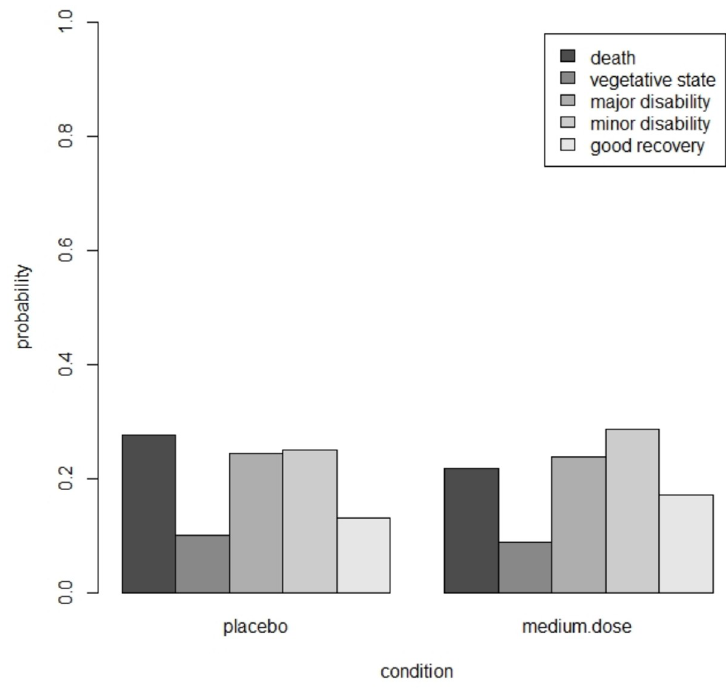
Fig 5. Estimated probabilities in the placebi and medium dose group in the trauma